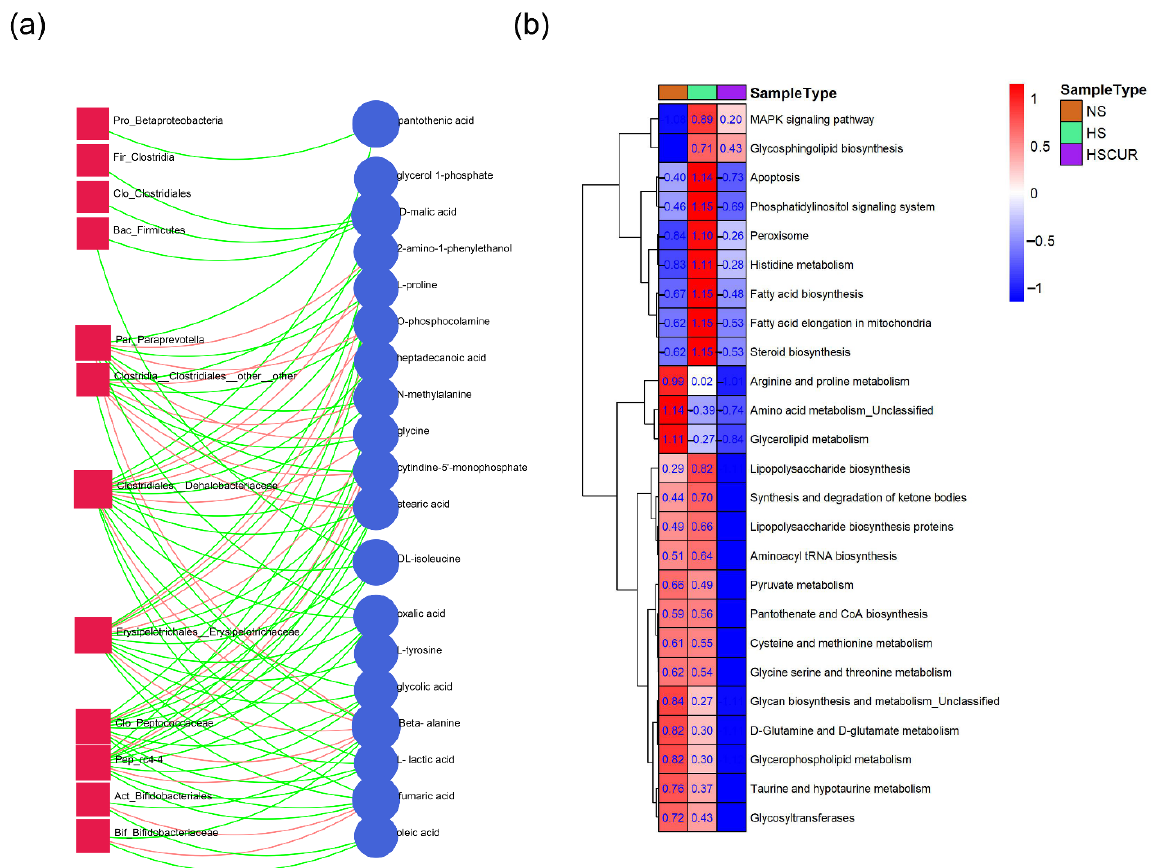
Figure 6. Integrated analysis of gut microbiota dataset and hepatic metabolomics dataset, and functional enrichment analysis based on microbial genomics. Integrated analysis of gut microbiota dataset and hepatic metabolomics dataset ( a ), functional enrichment analysis based on gut microbial genomics ( b ). The red squares represent the key differential microbiota, the blue circles represent the key differential hepatic metabolites, the red lines denote a positive correlation, and the green lines denote a negative correlation between microbial species and hepatic metabolites in figure a. In figure b, the red color represents high abundance and the blue color denotes low abundance, the numbers (scaled) in the block denote the relative abundance, Kruskal – Wallis test was used for screening the differential function pathways, and those pathways with raw p -values less than 0.05